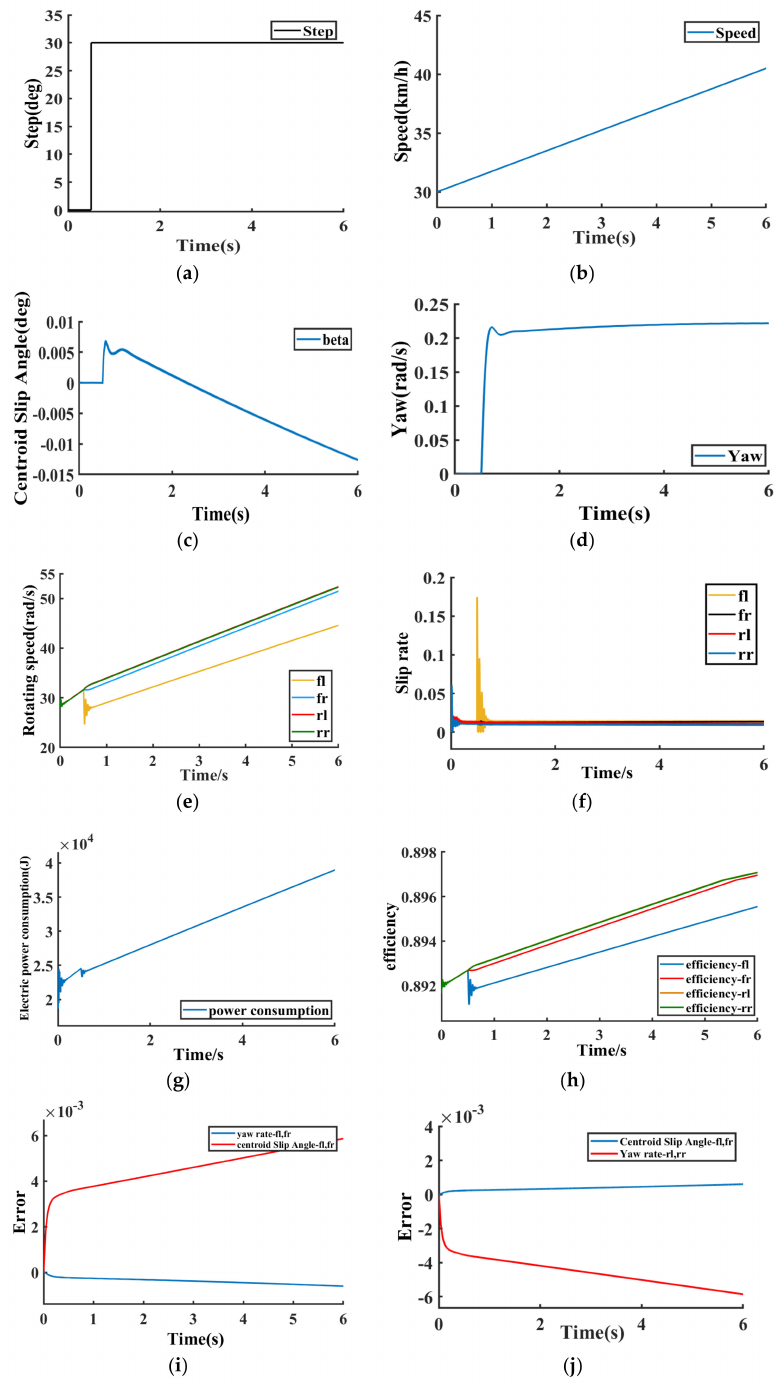
Figure 7. Accelerating turning condition. ( a ) Vehicle front wheel angle. ( b ) Vehicle speed. ( c ) Vehicle center of mass side slip angle. ( d ) Vehicle yaw rate. ( e ) Wheel speed. ( f ) Wheel slip rate. ( g ) Electric power consumption. ( h ) Efficiency. ( i ) fl, fr error. ( j ) rl, rr